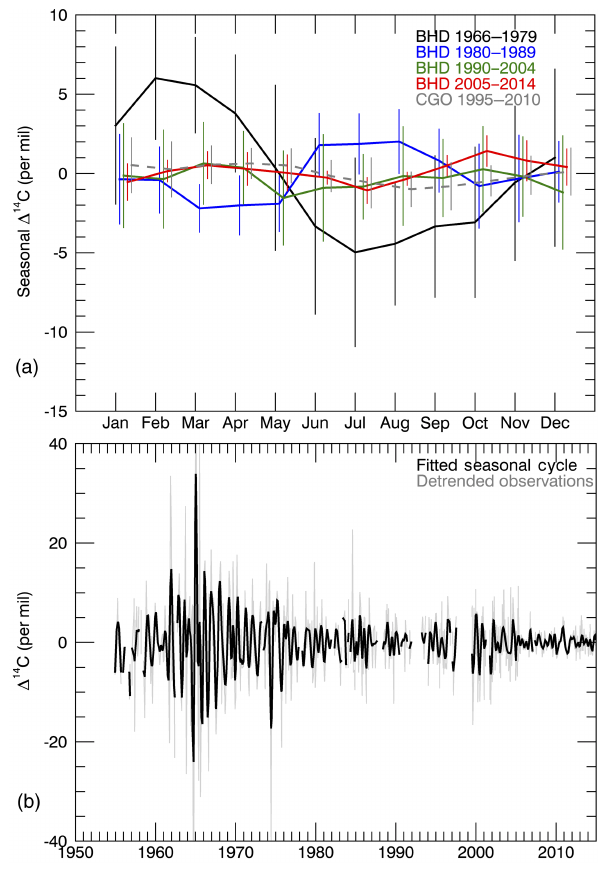
Figure 4. Detrended seasonal cycle in the Wellington (cid:49) 14 CO 2 record. (a) BHD monthly detrended seasonal cycle averaged over four time periods as described in the text and the CGO (Levin et al., 2010) detrended seasonal cycle. Error bars are the standard devia- tion of all years averaged. Points for each time period are slightly offset for clarity. (b) Full seasonal cycle record determined sepa- rately for each time period shown in (a) plus 1954–1965 (black) and detrended observations without any smoothing